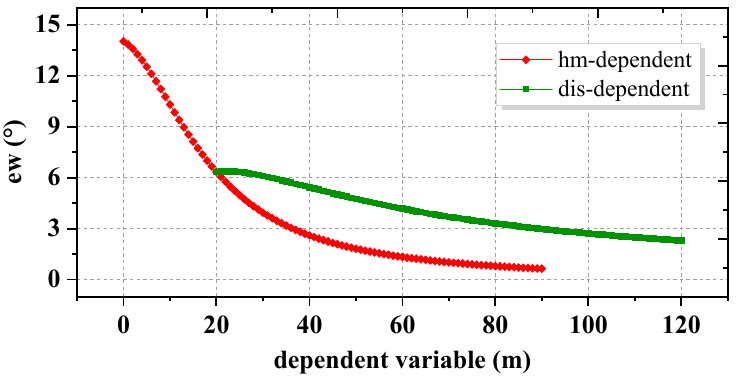
Figure 4. The relationships among 𝑒 (cid:3050) , ℎ (cid:3040) , and 𝑑𝑖𝑠 .